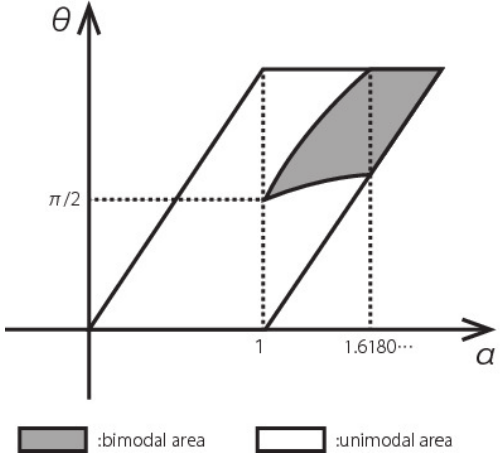
Fig. 2. Unimodality of monotone stable